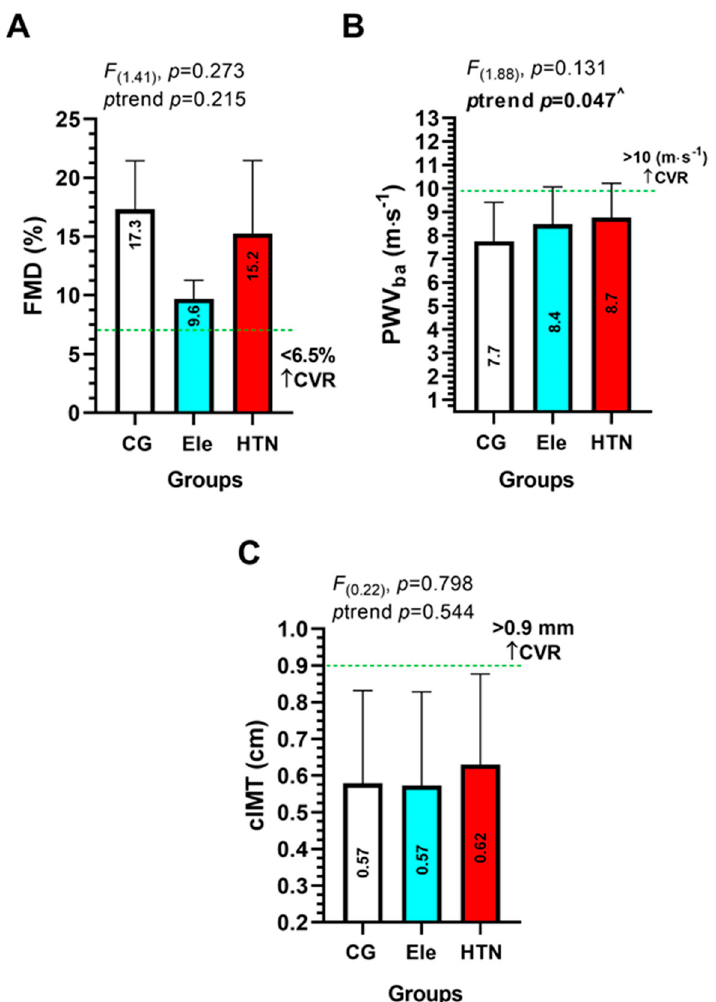
Figure 4. Endothelial dysfunction outcomes (flow-mediated dilation in % (panel A ), aortic pulse wave velocity (panel B )), and carotid-intima media thickness (panel C )) in three groups of adults with different blood pressure levels. Groups are described as: (CG) Control normotensive group, (Ele) Elevated blood pressure, and (HTN) arterial hypertension group. (FMD) Flow-mediated dilation in %. (PWVba) Pulse wave velocity of the brachial artery, and (cIMT) Carotid intima-media thickness. A green intermittent line denotes different adiposity and categorization cut-off points to FMD, PWVba, and cIMT. (CVR) Denotes cardiovascular risk limit. (^) Denotes a significant trend across groups at p < 0.05.